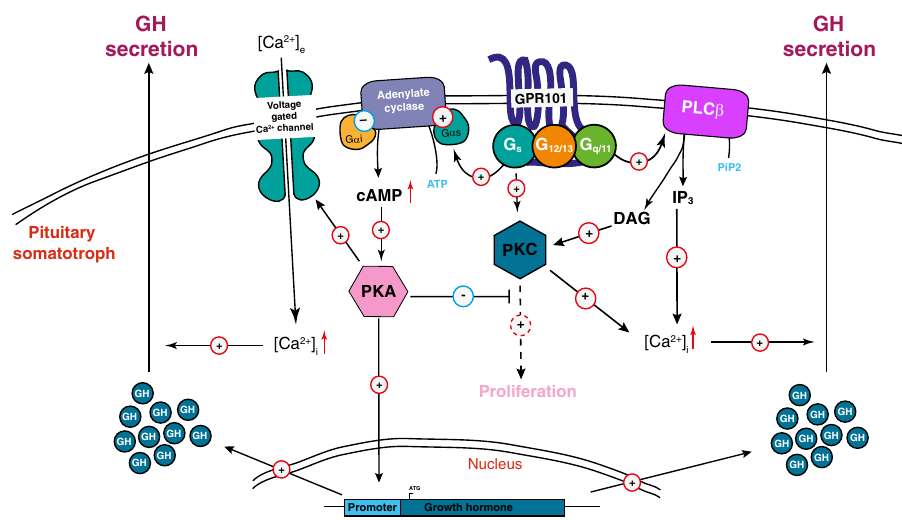
Fig. 8 Proposed model for GPR101-induced GH secretion. [Ca 2 + ] i : Intracellular Calcium; cAMP 3 ′ ,5 ′ -cyclic Adenosine Monophosphate, DAG Diacylglycerol, GH Growth Hormone, IP 3 Inositol Triphosphate, PIP 2 Phosphatidylinositol 4,5-bisphosphate, PKA Protein Kinase A, PKC Protein Kinase C, PLC β Phospholipase C β